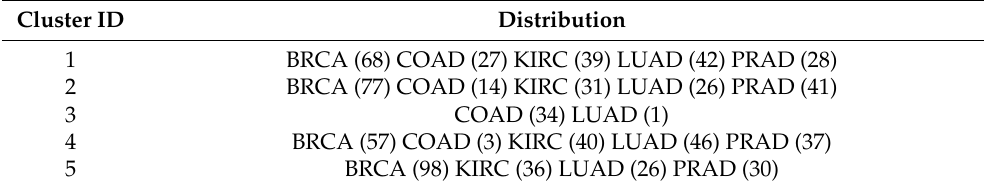
Table 7. The distribution of the hierarchical cluster assignments using k-means (default settings in R are used) and the gap statistic to select the number of clusters. The gap statistic suggests 5